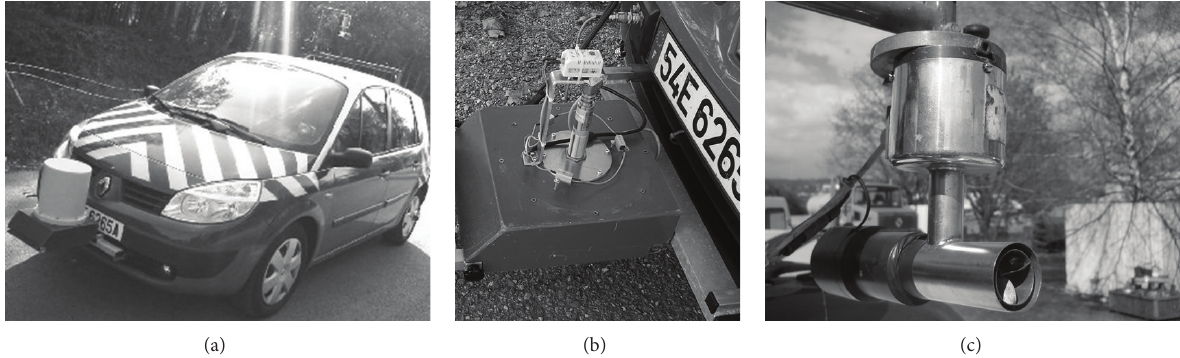
Figure 2: French thermal mapping vehicles and associated instruments (infrared radiometer (b) and atmospheric probe (c)).